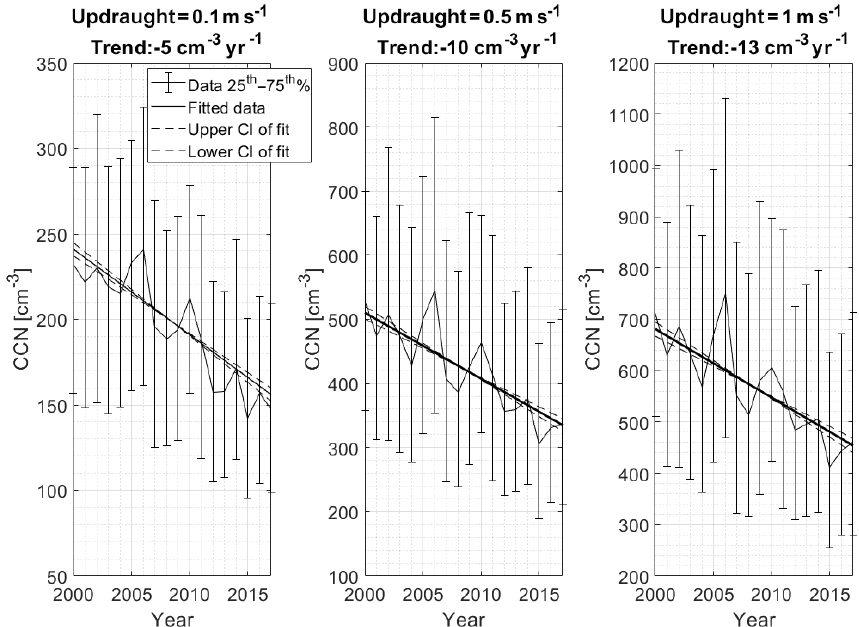
Figure 13. Trend of calculated CCN for different updraughts assuming a chemical composition ratio NH 4 SO 4 : organic of 50 : 50. The figure shows the median calculated CCN per year and corresponding 25th–75th percentile interval. The calculated linear trend as Theil–Sen slope and associated 95% confidence intervals are indicated by solid and dashed lines, respectively. Slope indicated in figure title. See text for further